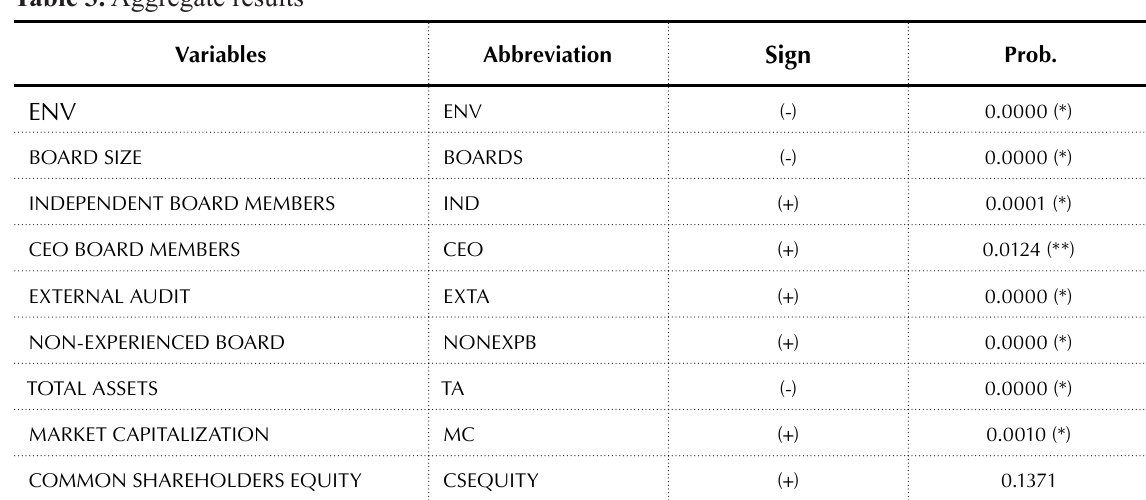
Table 3. Aggregate